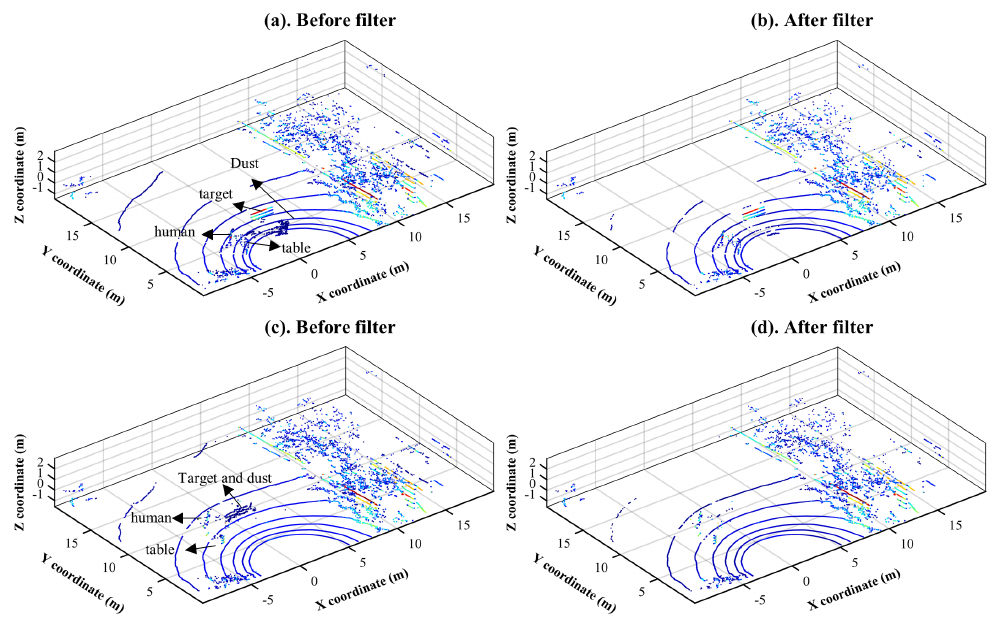
Figure 5. Experimental results after applying the developed LIOR de-dusting filters in two different scenarios: Point cloud map before filtering in case of experiment No. 1, first scenario ( a ); point-cloud map after LIOR filtering in case of experiment No. 1, first scenario ( b ); point-cloud map before filtering in case of experiment No. 2, second scenario ( c ); and point-cloud map after LIOR filtering in case of experiment No. 2, second scenario ( d